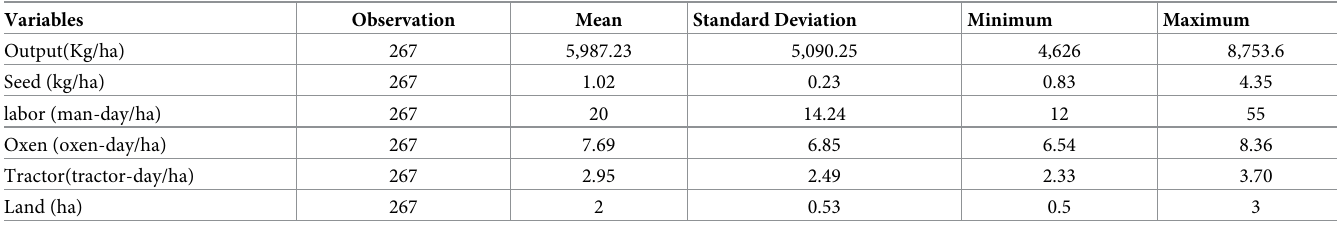
Table 3. Stochastic frontier production function variables